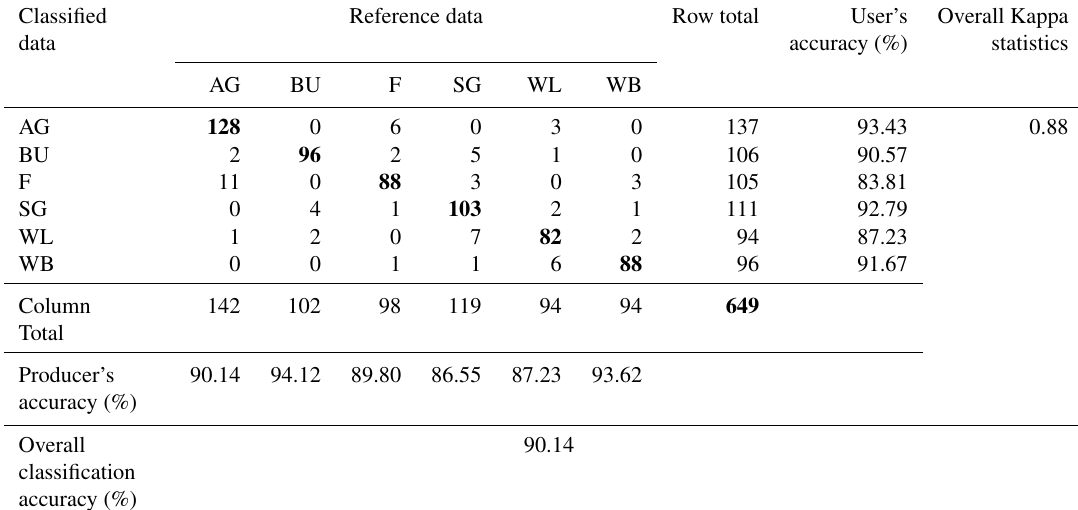
Table 4. Accuracy assessment of the 2012 LULC map produced from Landsat ETM + data, representing both the confusion matrix and the Kappa statistics. The bold values highlight the number of GCPs selected in each LULC class and total number of GCPs used in the accuracy assessment of the 2012 LULC map. AG = agricultural land, BU = built-up, F = forest, SG = snow/glacier, WL = wasteland and WB = water bodies.